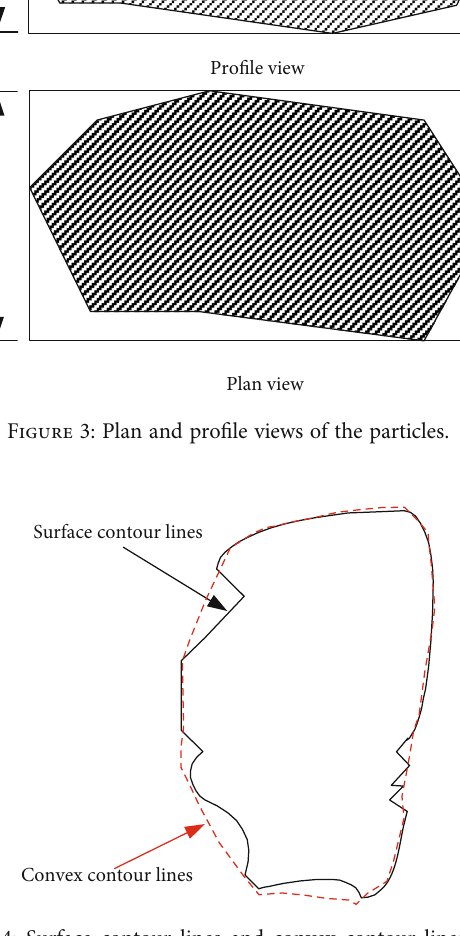
Convex contour lines Figure 4: Surface contour lines and convex contour lines of the particle